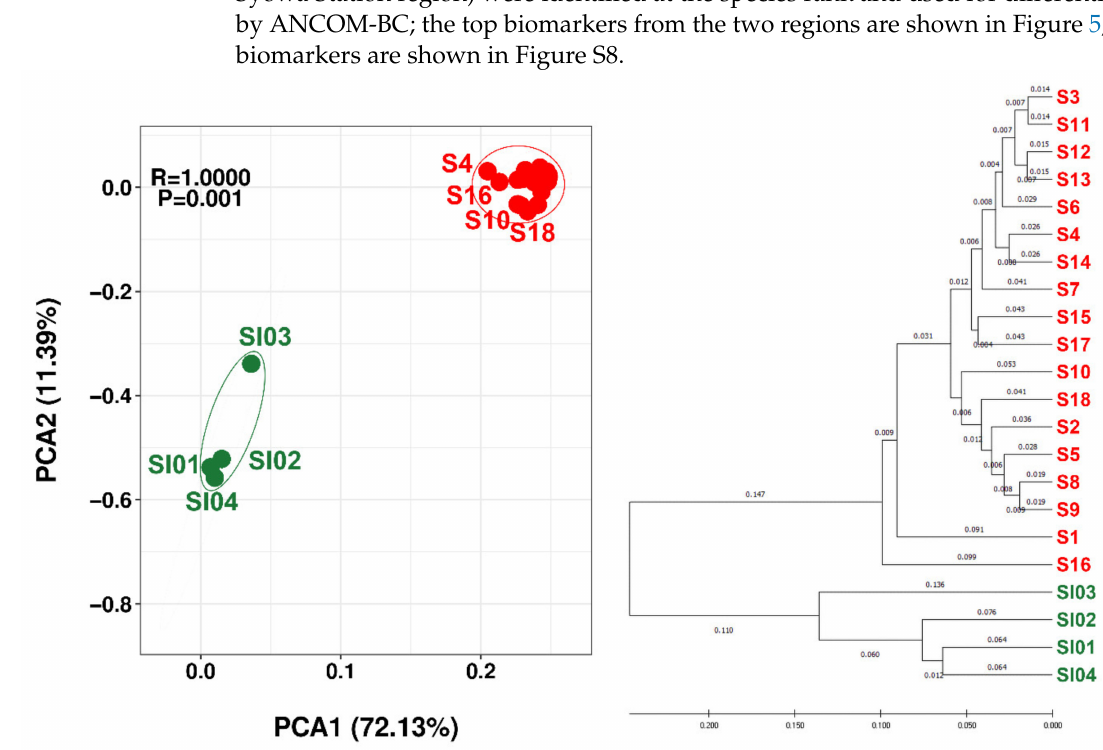
Figure 3. PCA plot ( left ) and hierarchical clustering dendrogram ( right ) of OTU-derived bacterial species obtained from lichens samples obtained on Signy Island (green) and the Syowa Station region (red). PCA plots at the genus, family, order, class and phylum ranks are shown in Figure S6.